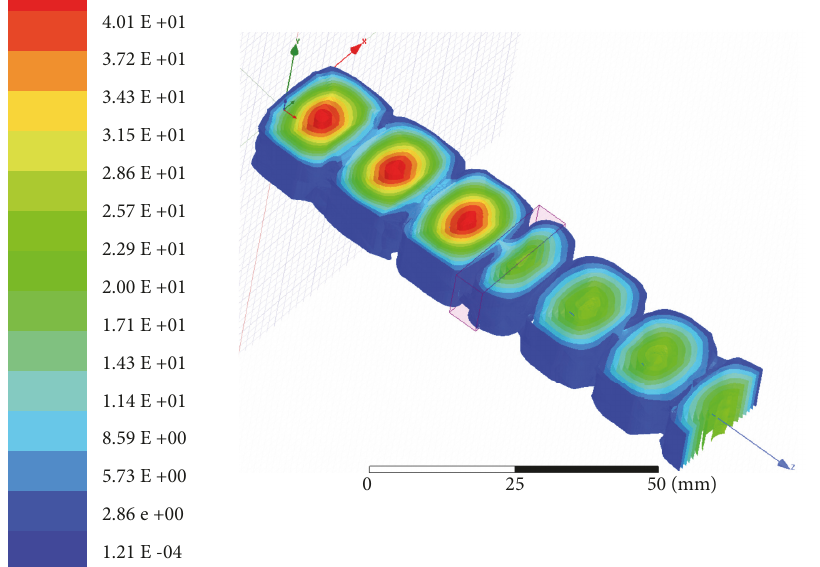
Figure 7: Instant configuration at 11.29 GHz and phase=90 ∘ for the magnitude of the electric field for TE 10